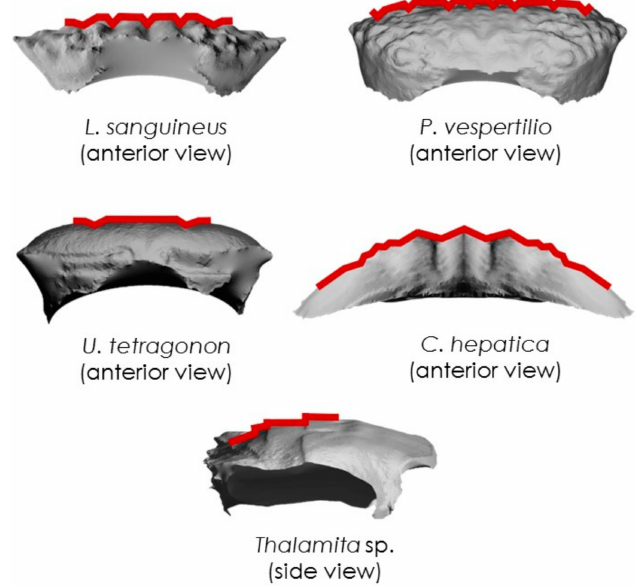
Figure 11. Representative examples of carapace grooves for each species. Figure 12 correlates the position of carapace grooves with distributed and localised